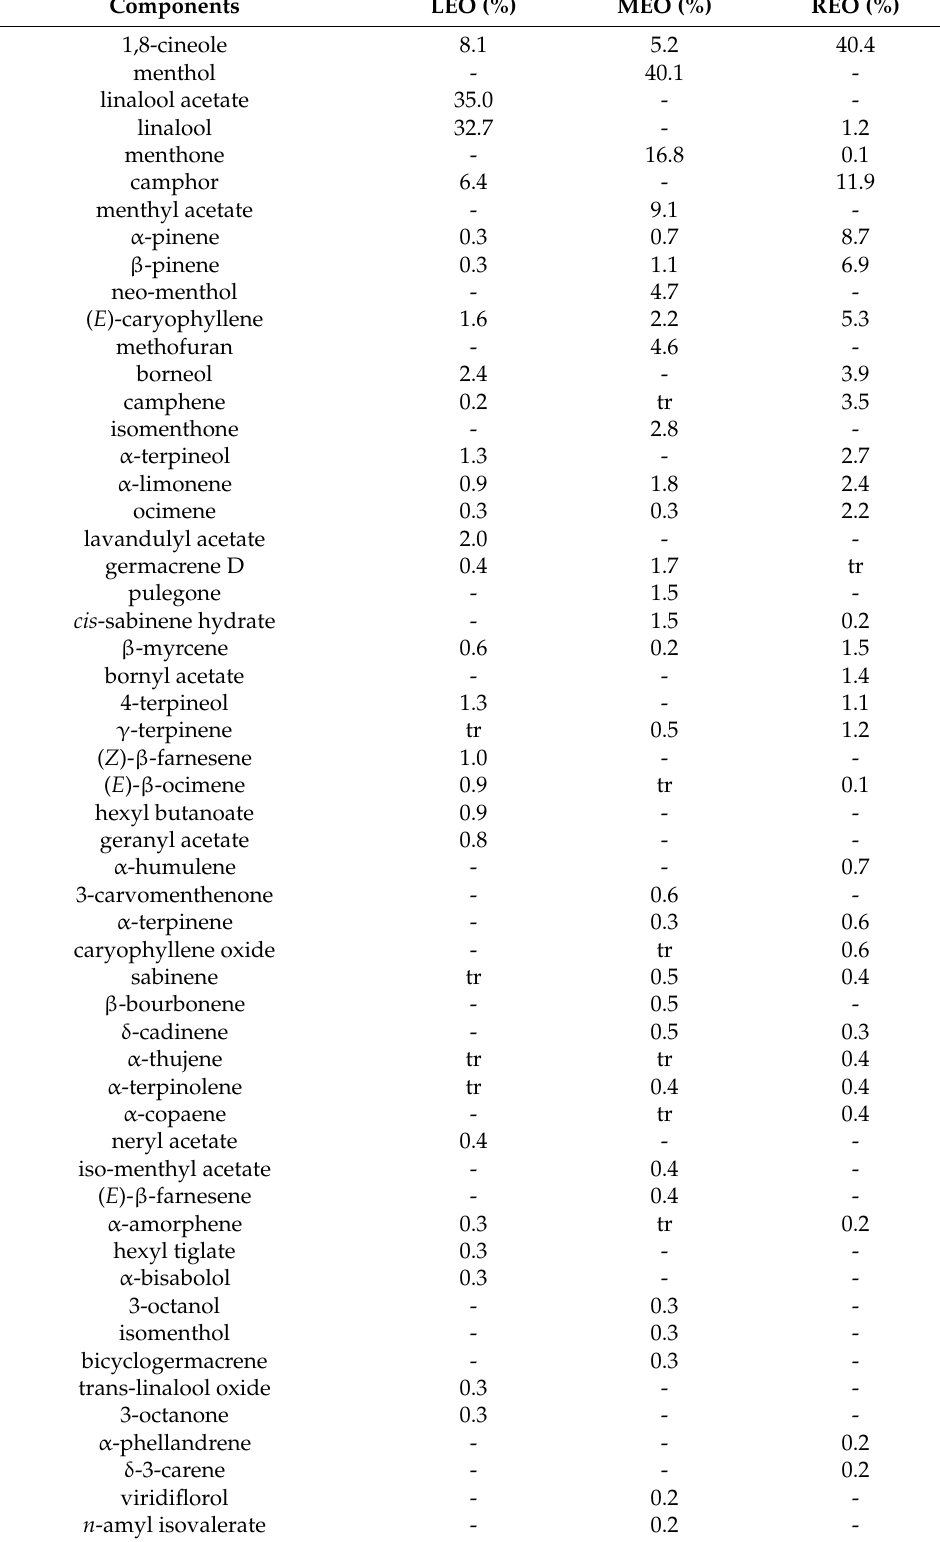
Table 1. Chemical composition of the analysed